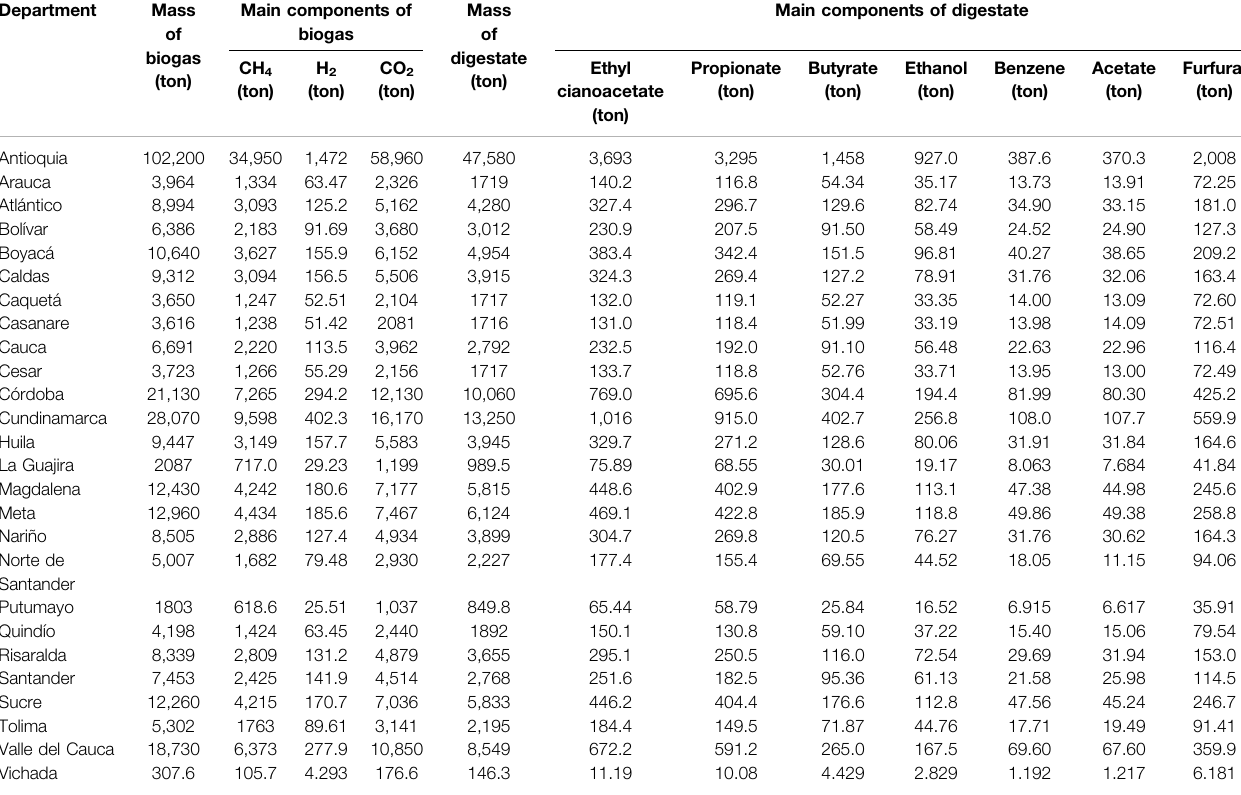
TABLE 4 | Total mass and main components of biogas and dried mass and main components of digestate obtained by ADF simulation according to the total availability of CFM, CCM, and SM in 2017 (inlet organic load 26 gCOD · l − 1 ).